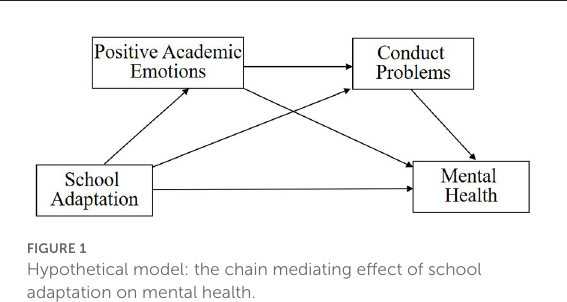
FIGURE1 Hypothetical model: the chain mediating effect of school adaptation on mental